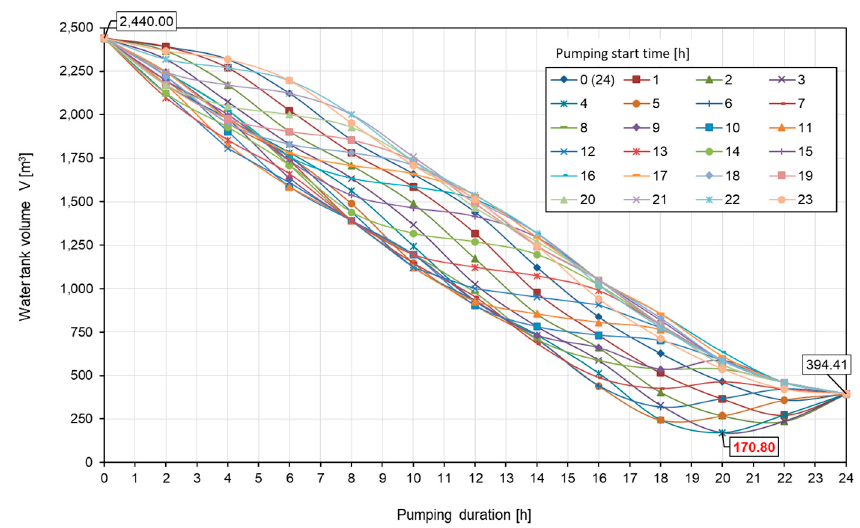
Figure 6. Changes in water tank volume V with respect to the different hours of pumping starts and different pumping durations for Variant I.